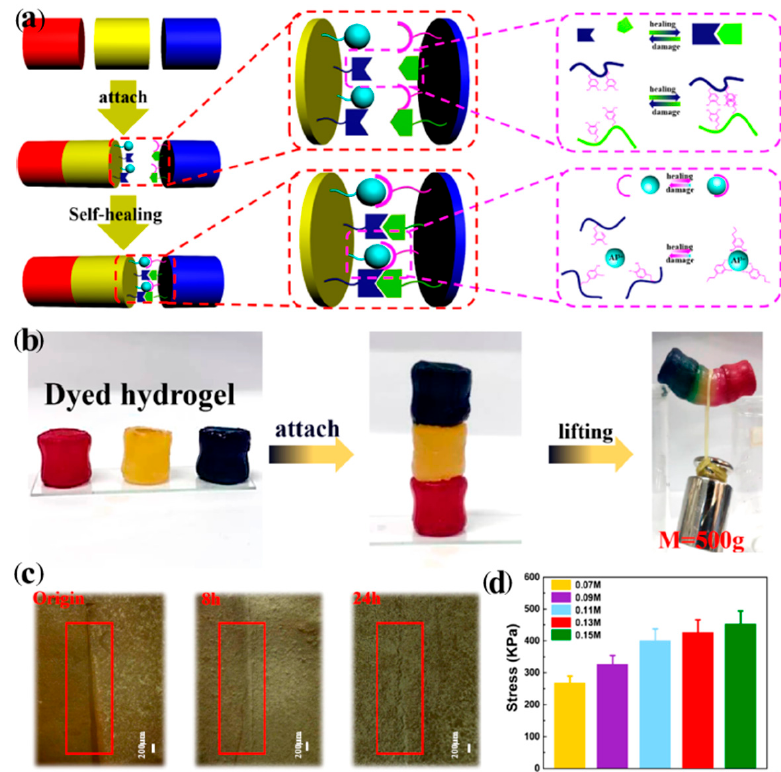
Figure 19. The self-healing in the mussel-inspired hydrogel system; ( a ) mechanism of self-healing process, ( b ) healing process and its experiment by lifting a weight, ( c ) ultra depth micrographs of damaged and healed samples, and ( d ) compressive modulus of hydrogels at various ion concentra- tions [107]. Adapted with permission from [107]. Copyright 2021 American Chemical Society.